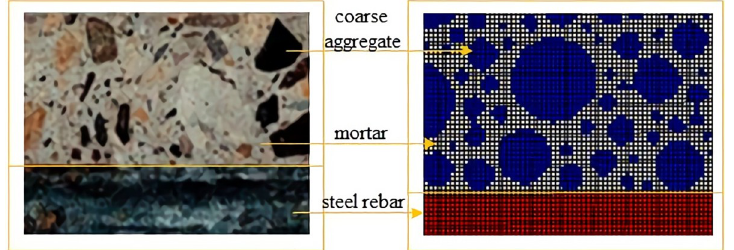
Fig 2. Mesoscopic bonding interface of reinforced concrete. a) Image of the real bonding interface zone. b) Mesoscopic finite element model of the bonding interface. The blue elements are coarse aggregates, the gray elements are mortar and the red elements are steel rebar. A grid size of 1mm � 1mm is taken to ensure the homogeneity of structural interior at mesoscopic